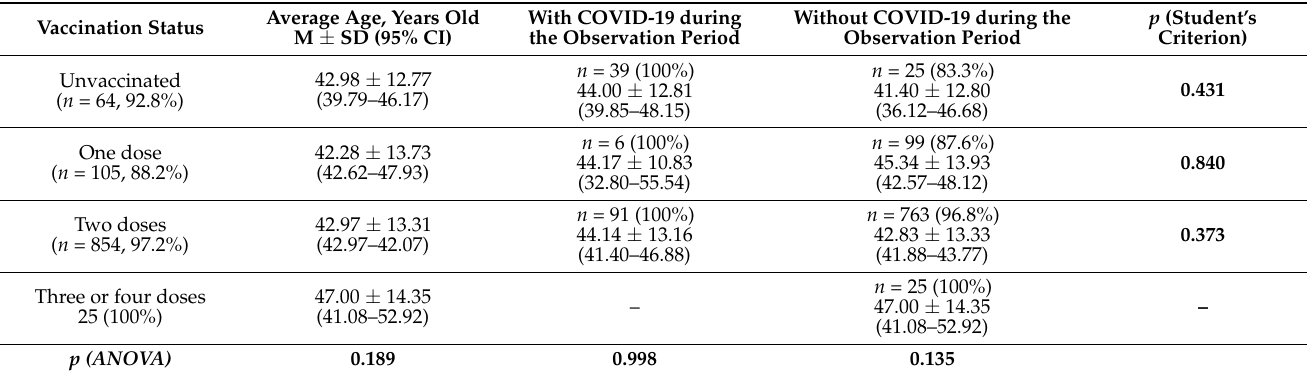
Table 2. Average age depending on vaccination status and COVID-19 history for the Delta variant of SARS-CoV-2 virus dominance